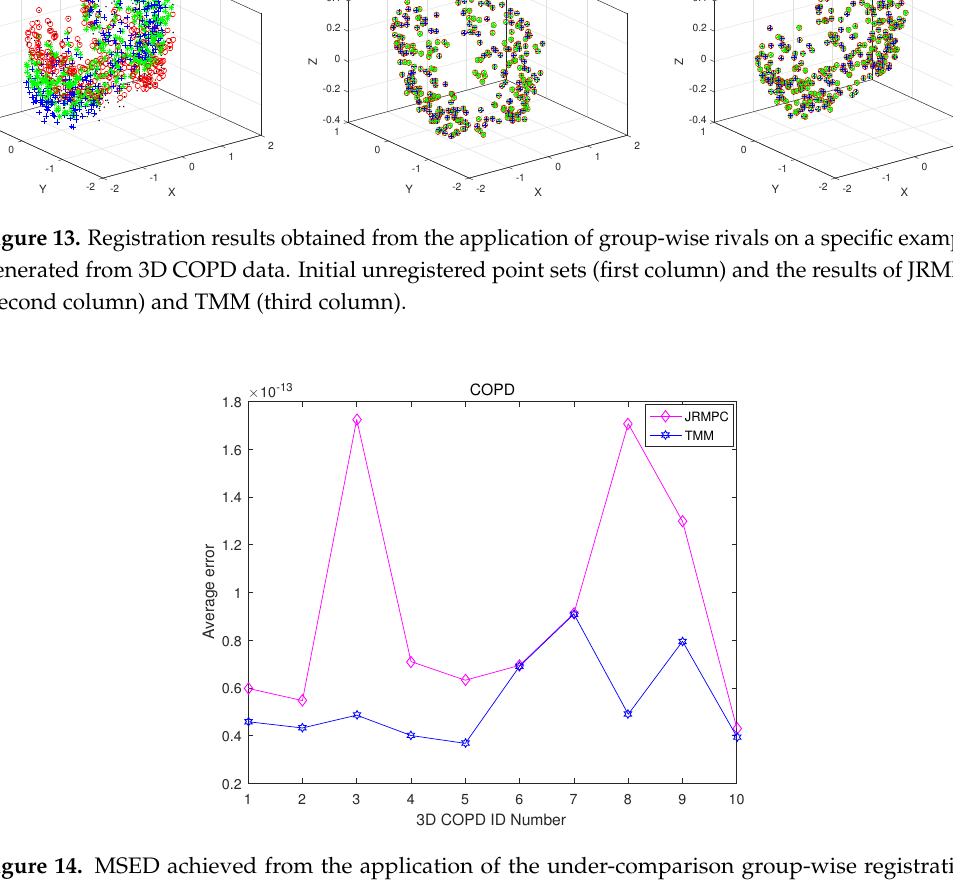
Figure 14. MSED achieved from the application of the under-comparison group-wise registration algorithms on multiple point set groups generated by 3D COPD data (please see text for the